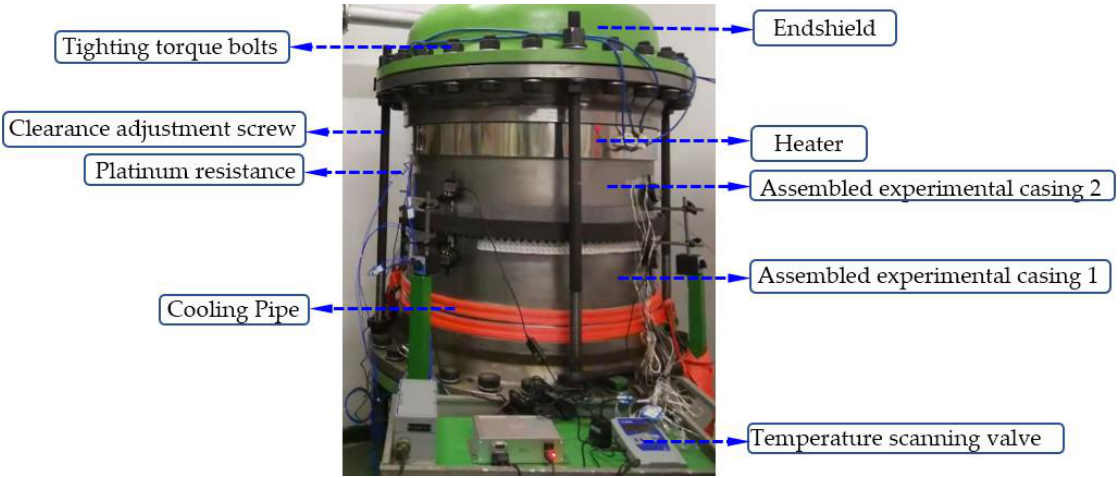
Figure 6. Structure diagram of the experimental bench.